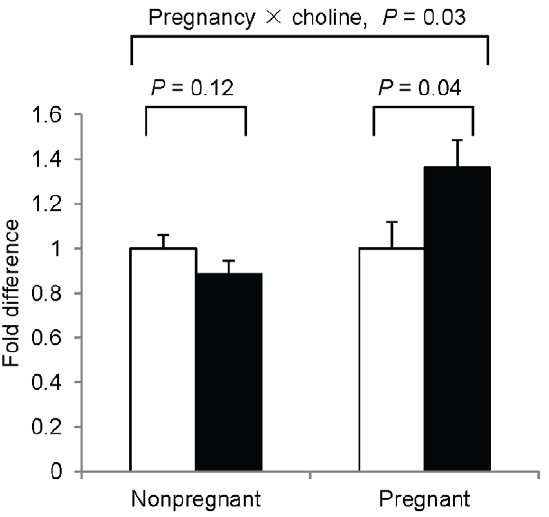
Figure 1. Effect of choline intake on peripheral blood leukocyte H3K4me2. The relative abundance of H3K4me2 at study-end in third trimester pregnant women (right) and nonpregnant women (left) consuming 930 versus 480 mg choline/d. White bar: 480 mg choline/d group, black bar: 930 mg choline/d group. n=10–13/choline intake and pregnancy status. Values are predicted means 6 SEM. Analyzed with general linear models.